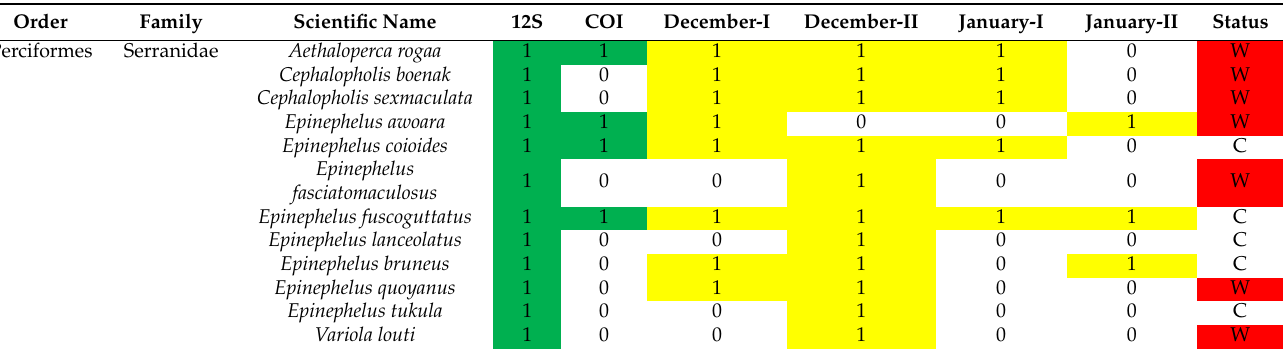
Table 6. List of Serranidae species detected in this study.